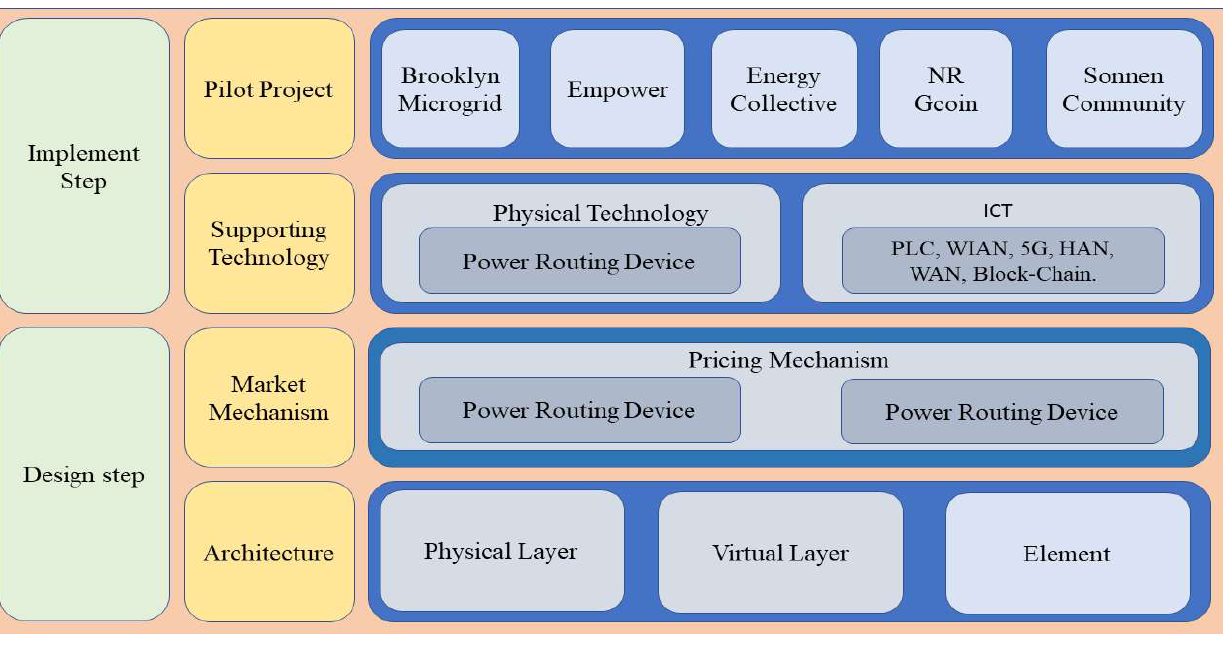
Figure 4. Research topics related to P2P energy trading and the scope of this review.